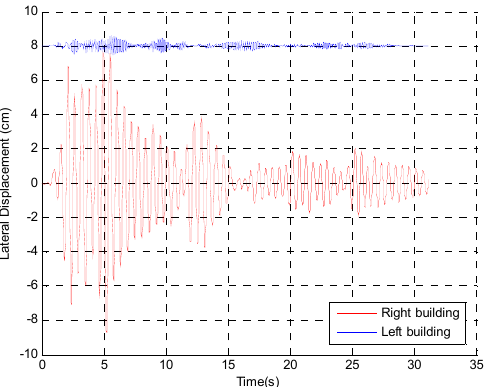
Figure 8. The lateral displacement time histories of buildings separated by the seismic gap of 7.98 cm.